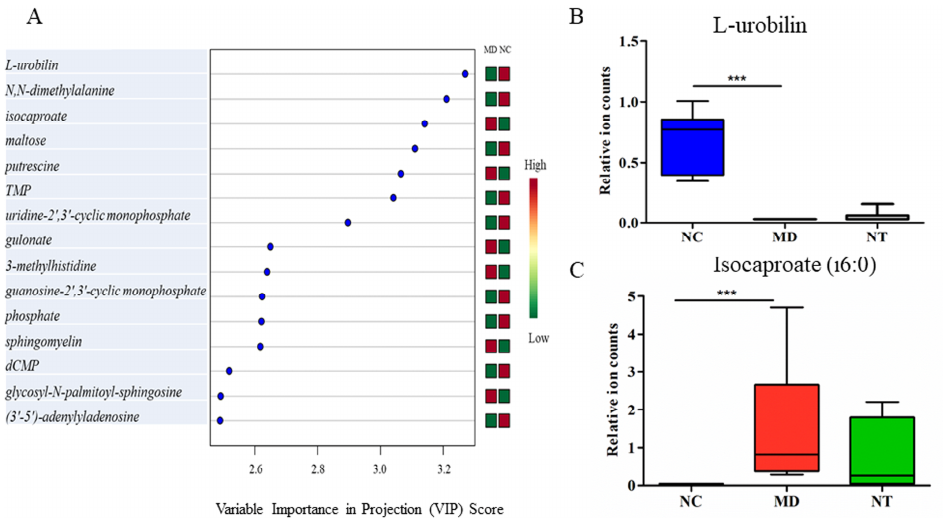
Figure 6. Urobilin related pathways dysregulated in a colitis murine model induced by dextran sulfate sodium. ( A ) Partial least squares discriminant analysis (PLS-DA) identified L-urobilin, N, N-dimethylalanine and isocaproate as the top three important metabolites that were discriminative of the colitis phenotype. ( B ) Gut luminal L-urobilin concentrations were significantly reduced by DSS. ( C ) Isocaproate levels were significantly higher in colitis mice. NC: normal controls; MD: colitis induced by DSS; NT: DSS induced colitis mice supplemented with NT. *** p <